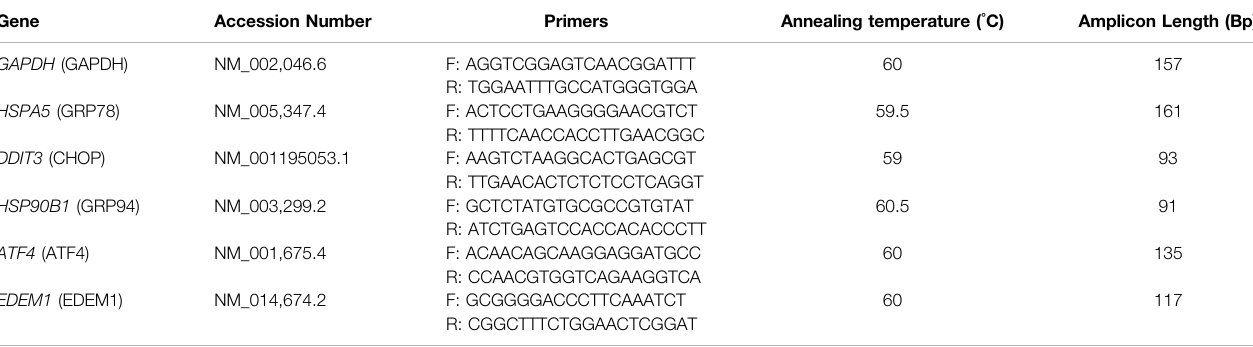
TABLE 1 | Data concerning analyzed genes and designed primer